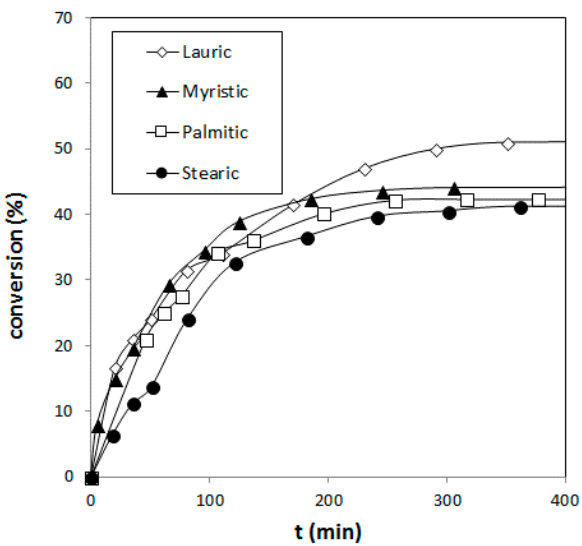
Figure 7. Conversion profiles versus time for the 1:1 esterification of different acids with methanol at 70 °C with Amberlyst-15. Energies 2018 , 11 , x FOR PEER REVIEW